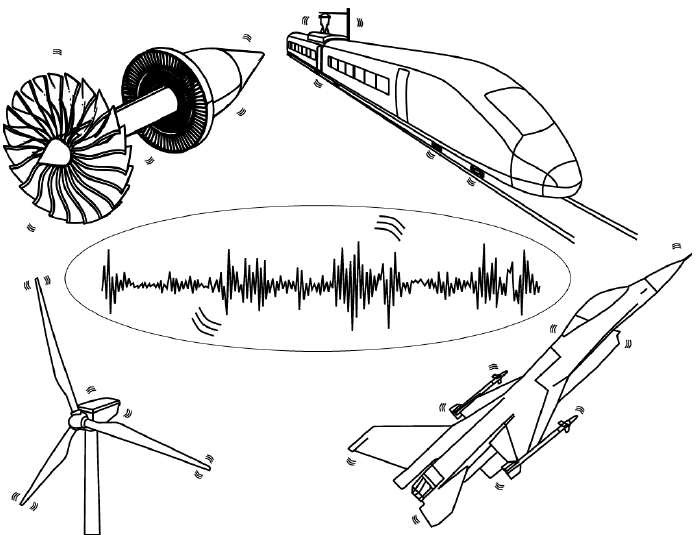
Figure 1. Various engineering applications are featuring acoustic-wall effects and vibration induced by aerodynamic loading: high-speed aircraft, turbomachinery, wind turbines, and high-speed trains. On the other hand, fine-grain numerical simulations that capture turbulence and acoustic effects take several days or weeks on several high-performance computing